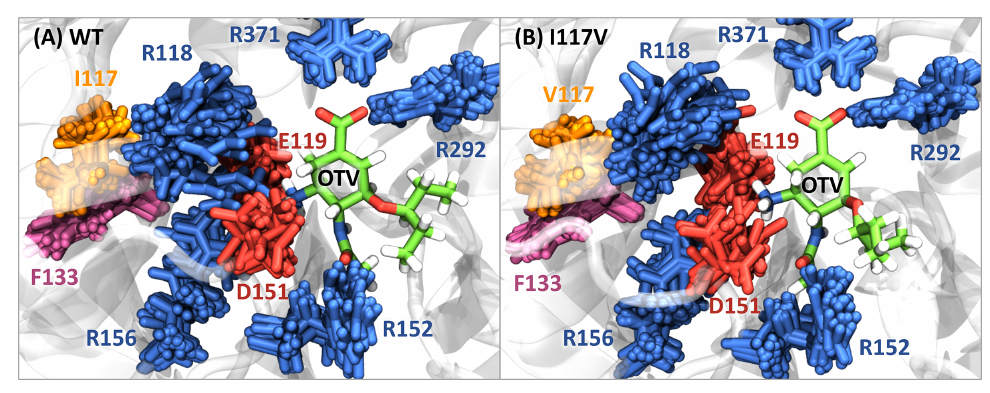
Figure 5 Superimposed snapshot images for the neuraminidase-oseltamivir complexes. (A) Wild- type (WT) and (B) I117V mutant NA-OTV complexes. OTV is represented in green, and residue 117 is indicated in orange. The positively charged residues (R118, R152, R156, R292, and R371) in the OTV binding site are represented in blue, and the negatively charged residues (E119 and D151) are represented in